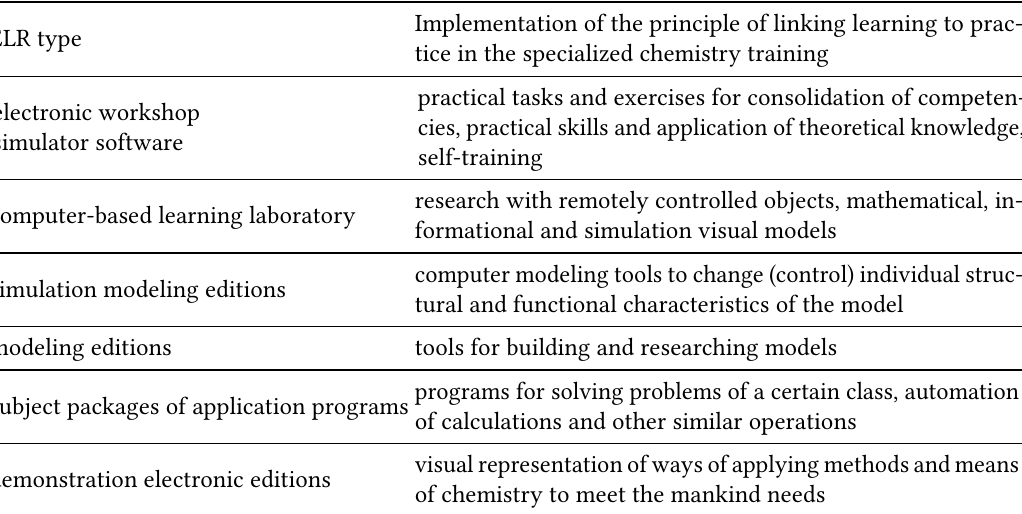
Table 2 ELRs for implementing the principle of linking learning to practice in the specialized chemistry